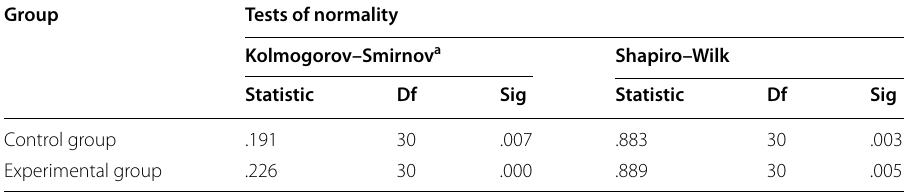
Table 5 Kolmogorov–Smirnov tests of normality between the experimental and control groups Group